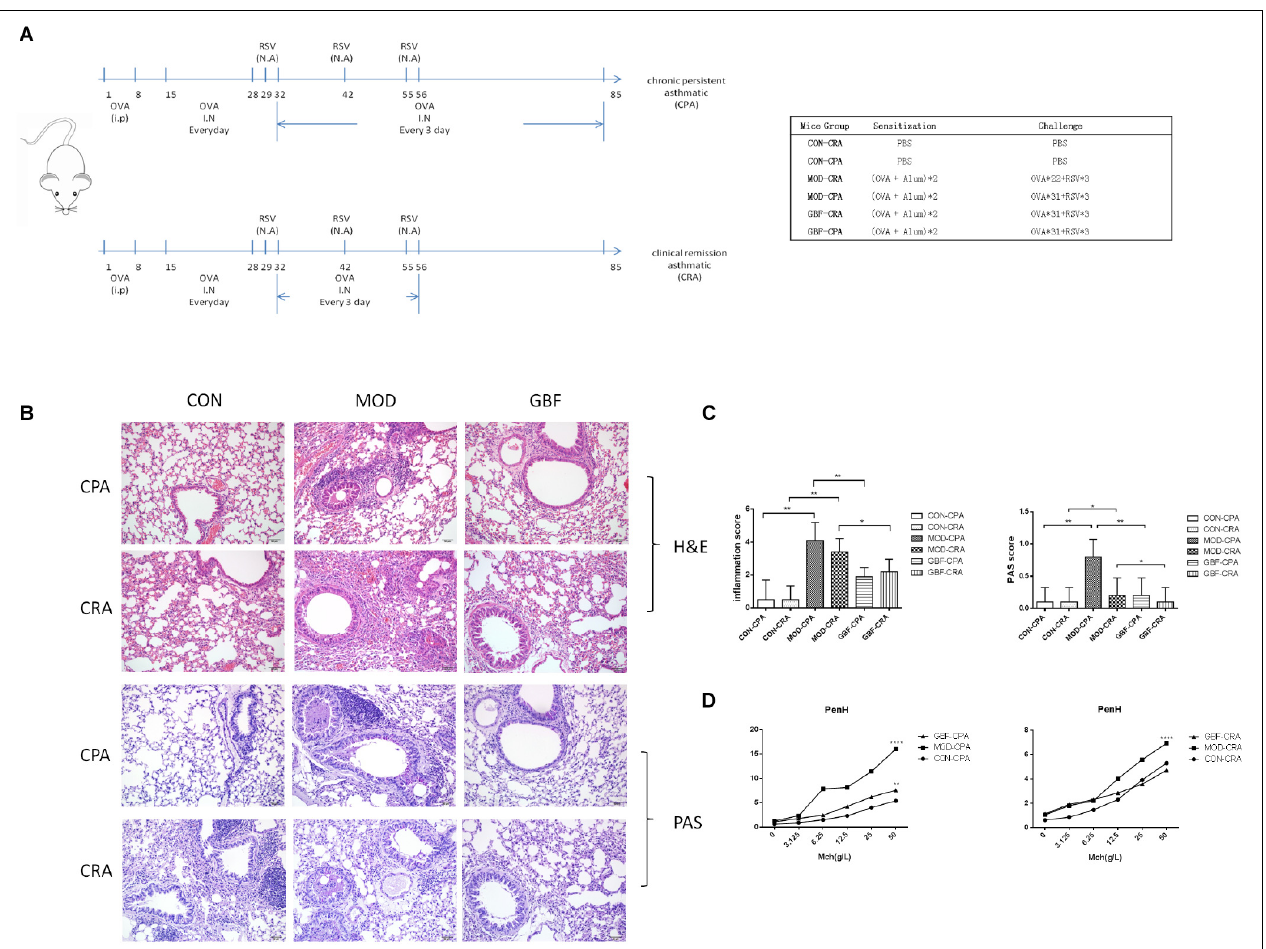
FIGURE 1 | Effect of GBFXD treatment on airway hyperresponsiveness in ovalbumin-challenged mice and histological examination of lung tissue for airway inflammation (H&E and PAS staining). (A) Experimental scheme for the induction of airway inflammation in a mouse model. (B) H&E staining showing asthmatic inflammation. PAS staining identified epithelial goblet cells. (C) Total inflammation scores in all animal groups. The percentage of PAS-positive cells per bronchiole was calculated. (D) Airway responsiveness to aerosolized methacholine was measured with WBP. Mice were placed in the main chamber and nebulized first with PBS and then with increasing doses (3.125–50 mg/mL) of methacholine. Data represent the mean ± SEM of five independent experiments (two-way ANOVA by Tukey’s multiple comparisons test; ∗∗ p < 0.01; ∗∗∗ p < 0.0001; ∗∗∗∗ p < 0.0001).